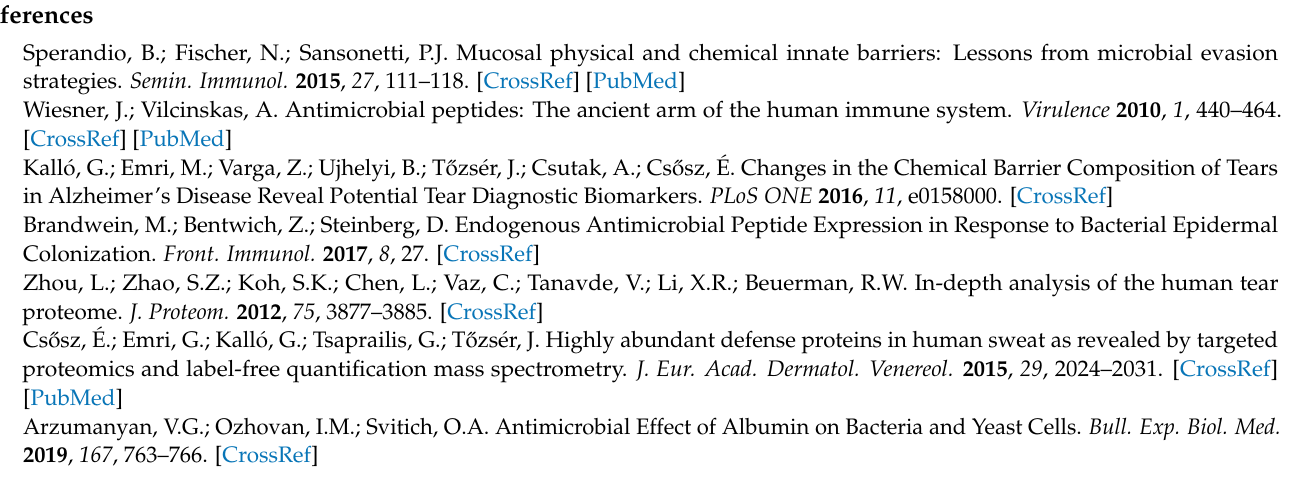
Table S3: Proteins involved in the first line of host defense in saliva; Table S4: Proteins involved in the first line of host defense in the nasal secretion; Table S5: Proteins involved in the first line of host defense in sweat; Table S6: Proteins involved in the first line of host defense in urine; Table S7: Proteins involved in the first line of host defense in CSF; Table S8: Proteins involved in the first line of host defense in cervicovaginal fluid; Table S9: Proteins involved in the first line of host defense in the seminal